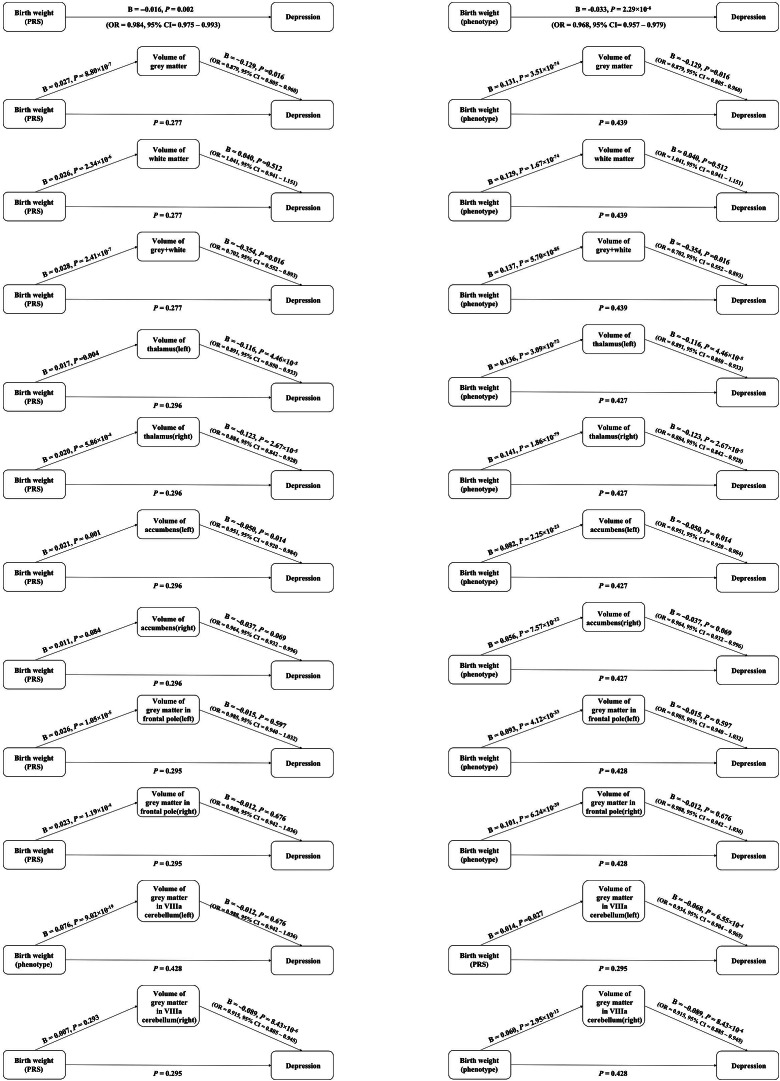
Association between birth weight and depression via elevated levels of one of brain volumes through steps approach. Birth weight polygenic risk scores (PRS) indicates the polygenic scores for birth weight. Birth weight phenotype means the phenotype of birth weight.